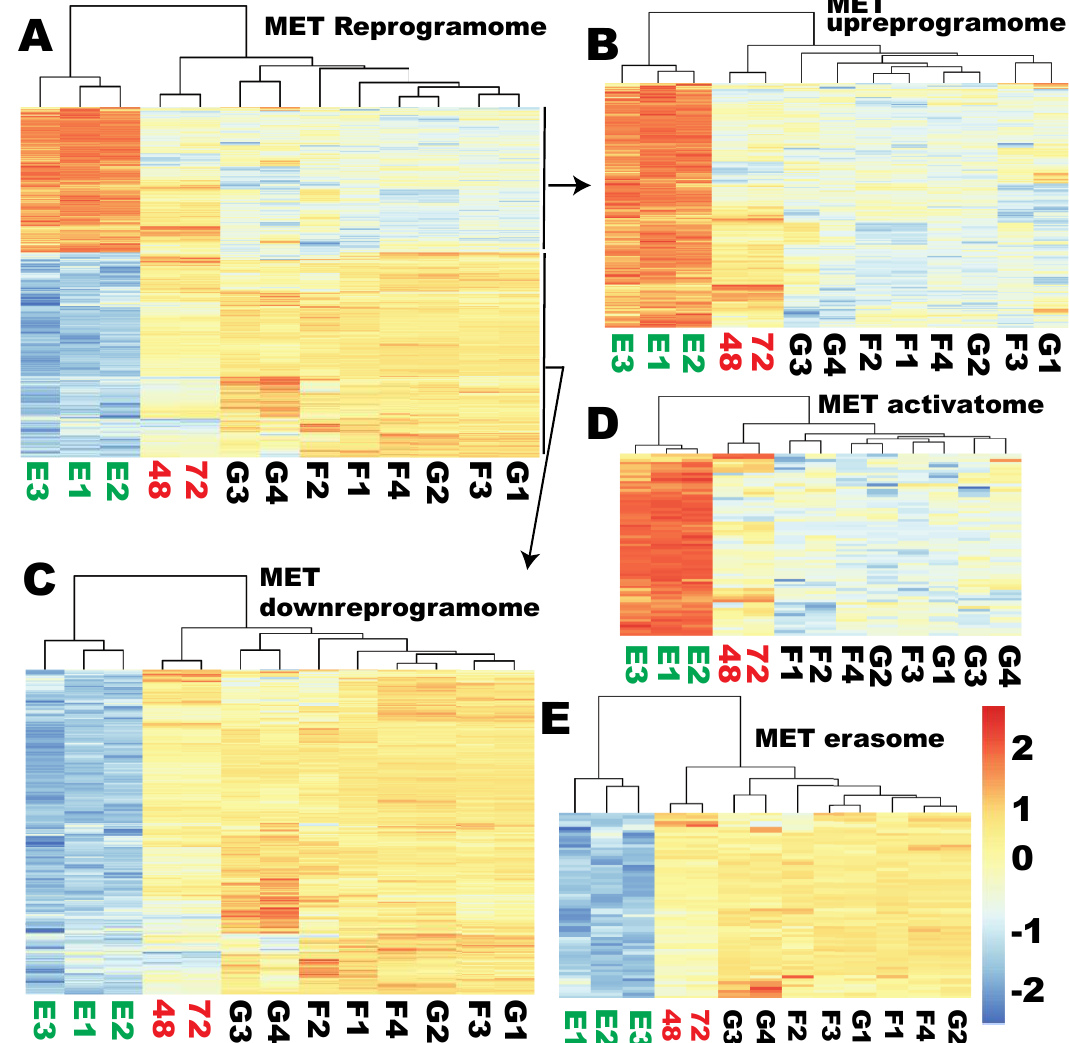
Figure 5. MET reprogramome and its subreprogramomes were not reprogrammed at the time of proper RB reprogramming. Clustering analyses and associated heat maps showing similarity of the reprogramming cells to the starting fibroblasts and GFP-transduced fibroblast controls and dissimilarity to hESCs for the entire MET reprogramome ( A ), upreprogramome ( B ), downreprogramome ( C ), activatome ( D ), and erasome ( E ). G1 to G4: GFP-5, GFP72-8a, GFP48-5, and GFP72-8; F1 to F4: BJ48-4, BJ72-7, BJ48-1, and BJ72-4; E1 to E3: human embryonic stem cell H1, H9, and hESC; 48 and 72: RNA harvested from human fibroblasts 48 and 72 h post transduction with lentiviral reprogramming factors